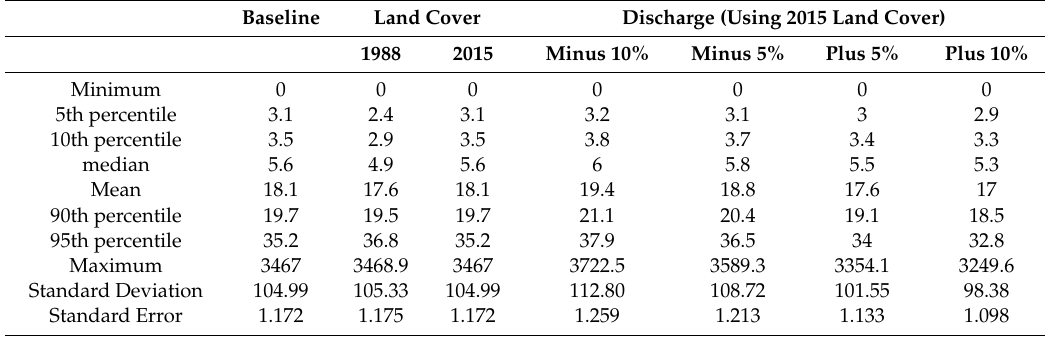
Table 3. Sensitivity analyses of the e ff ect of changes in land cover and discharge on total phosphorus concentration ( µ g P / l) for 8030 standing